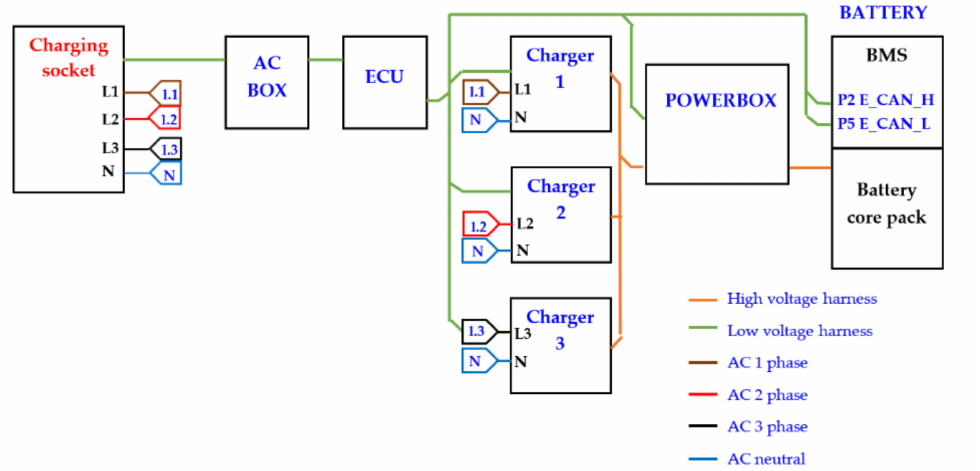
Figure 3. Overall scheme of the Type 3 and Type 1 charging